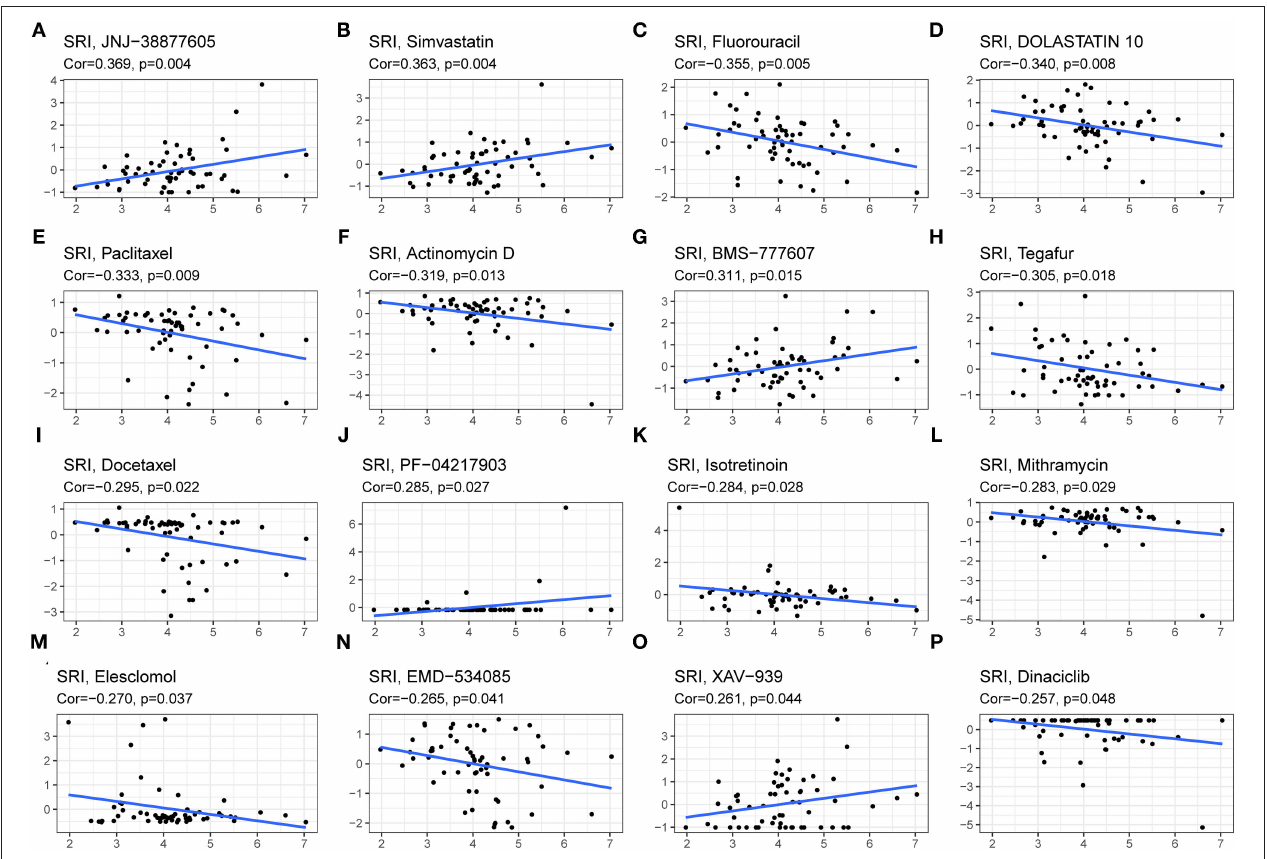
FIGURE 10 | The drug sensitivity analysis of SRI. The SRI expression was positively associated with drug sensitivity of JNJ-38877605 (A) , Simvastatin (B) , BMS-777607 (G) , PF-04217903 (J), and XAV-939 (O) . The SRI expression was negatively associated with drug sensitivity of Fluorouracil (C) , DOLASTATIN 10 (D) , Paclitaxel (E) , Actinomycin D (F) , Tegafur (H) , Docetaxel (I) , Isotretinoin (K) , Mithramycin (L) , Elesclomol (M) , EMD-534085 (N) , and Dinaciclib (P) . X -axis represents the SRI expression level and Y -axis represents the scores of drug sensitivity.